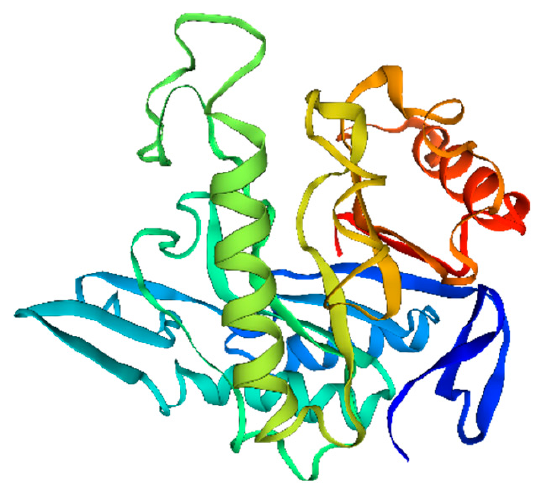
Figure 2. Three-dimensional structural model of F1 mannanase.